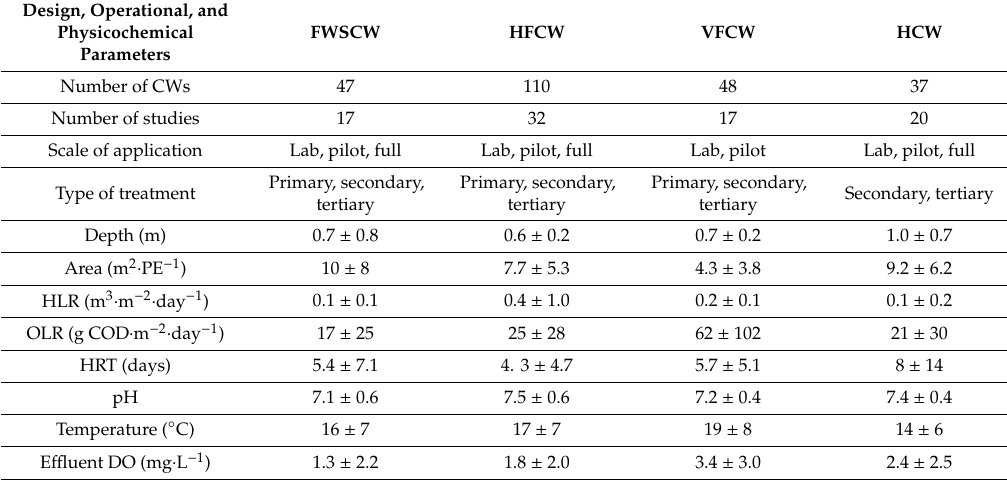
Table 2. Summary of selected design, operational, and physicochemical parameters of the studied four types of